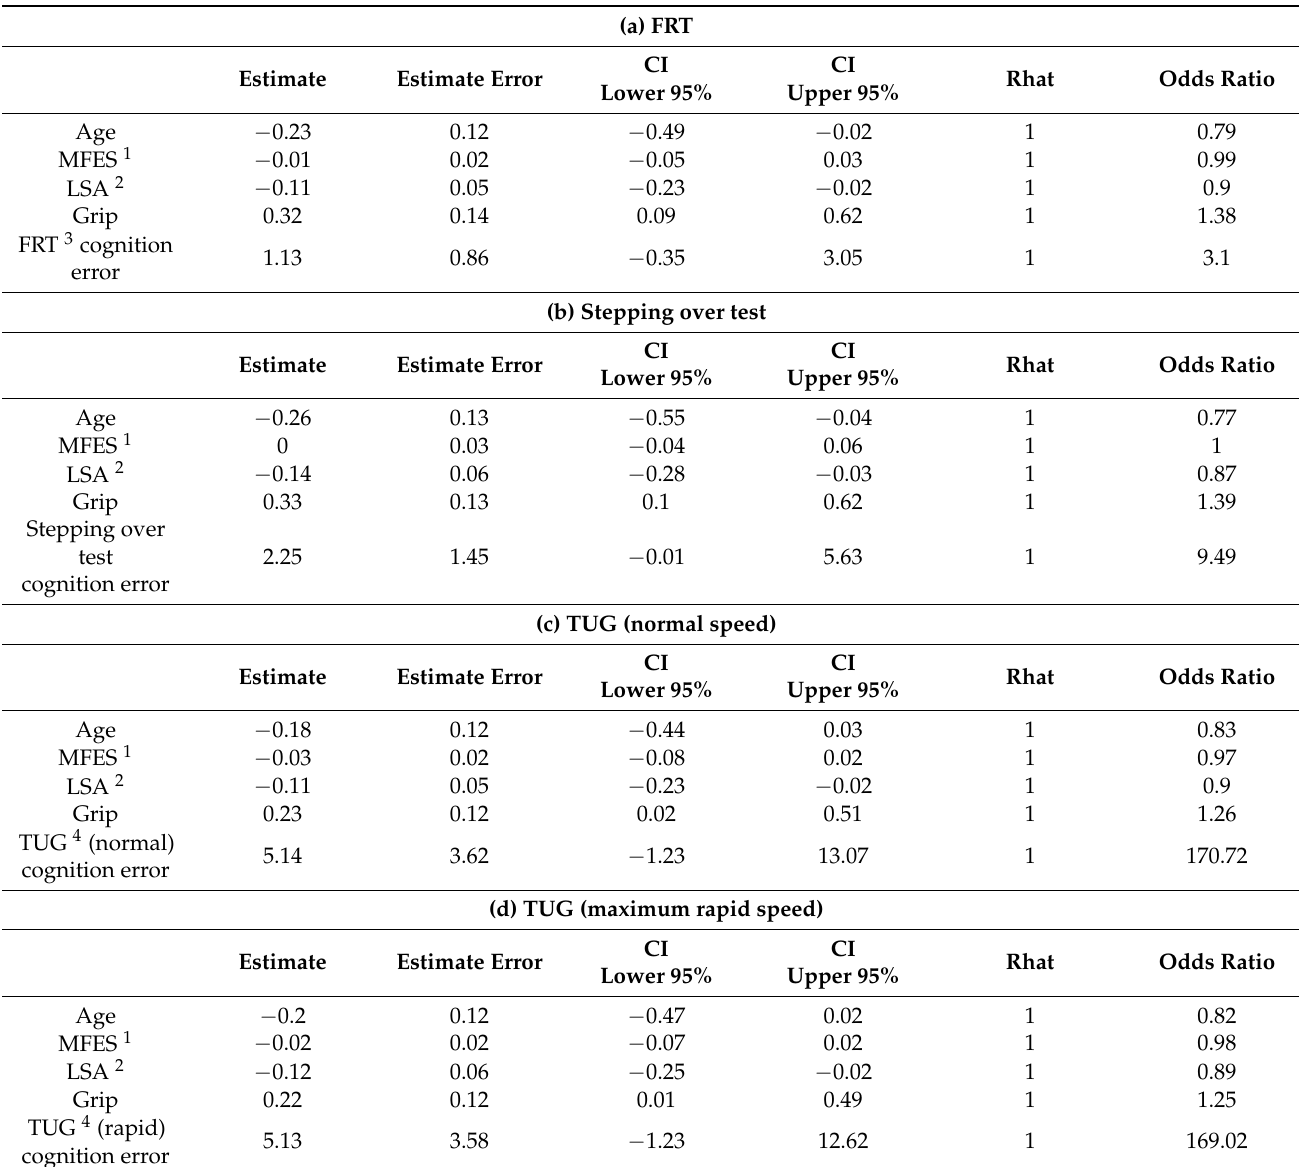
Table 4. Association between fall history and each factor by logistic regression analysis with each cognition error added as a variable ( a – d ). (a)